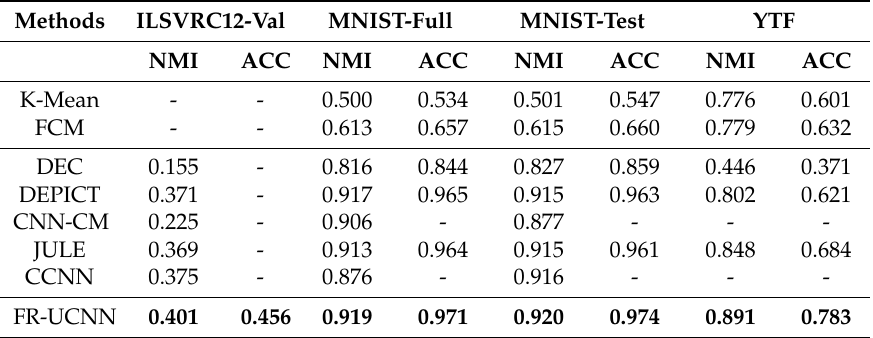
Table 4. Comparison between the Different Clustering Algorithms Based on Clustering Performance (NMI &